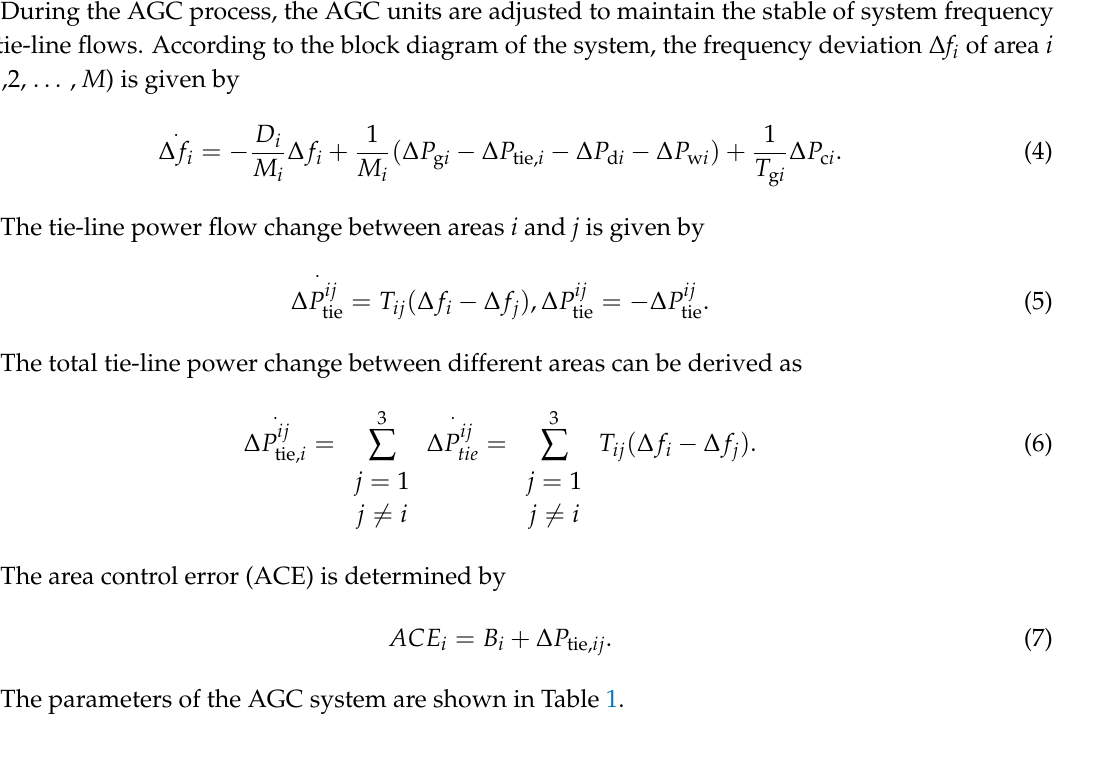
Figure 2. Block diagram of AGC system with thermal power.